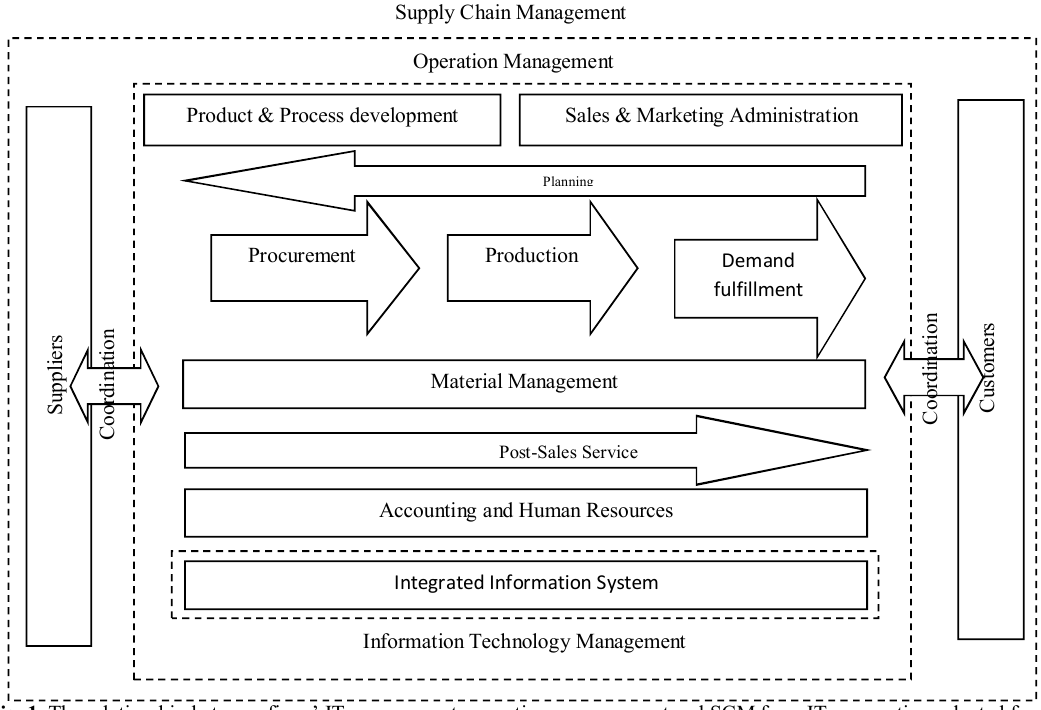
Fig. 1. The relationship between firms’ IT management, operations management and SCM from IT perspective, adapted from SAP Inc’s presentation slides (Zhang & Dhaliwal,